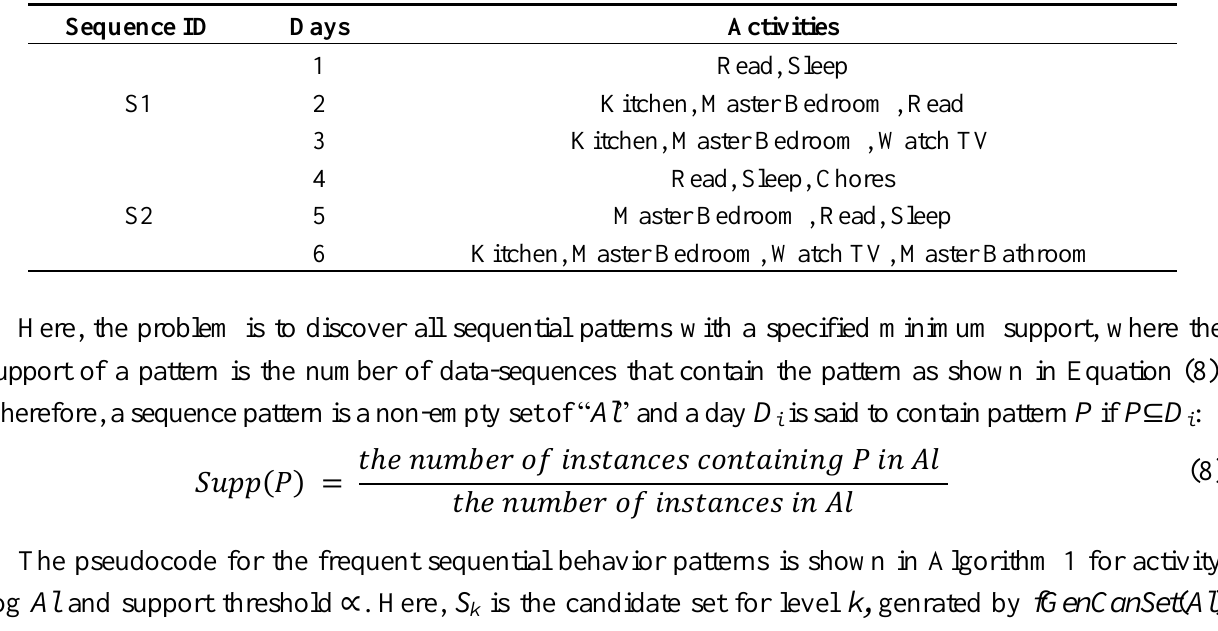
Table 1. Representative repository of an activity